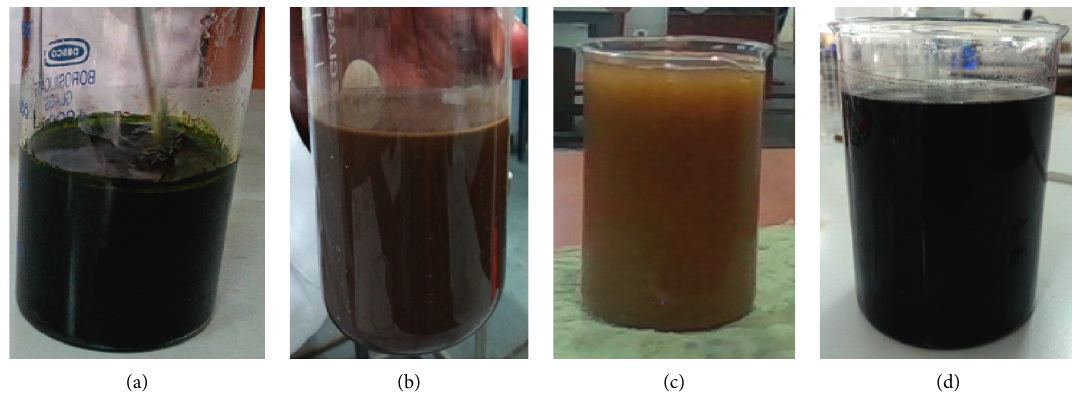
Figure 1: The color change observed during the stepwise synthesis of reduced graphene oxide.